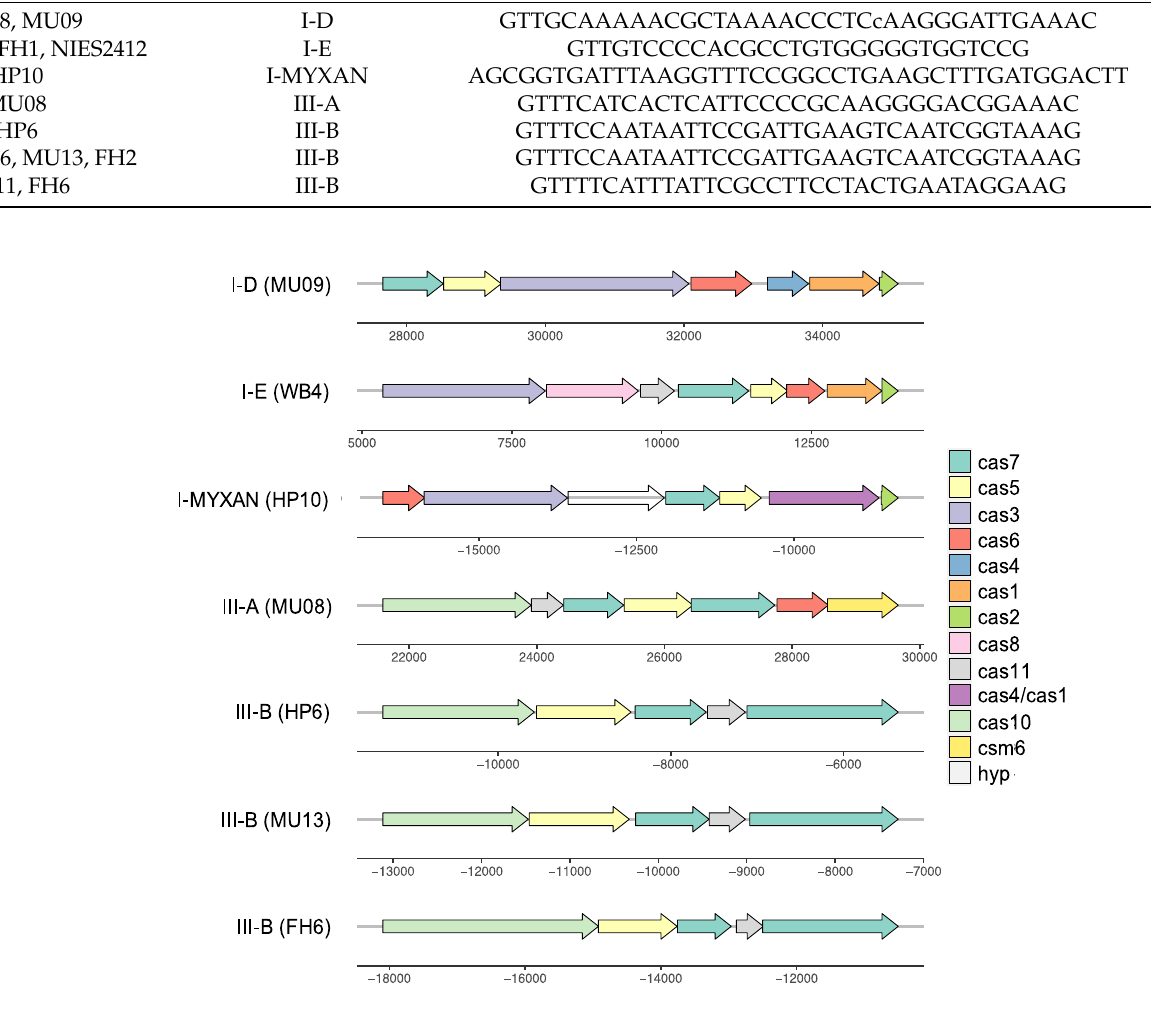
Figure 7. Representative gene maps for CRISPR-Cas systems detected in A. marina genomes (strain is indicated in parentheses).